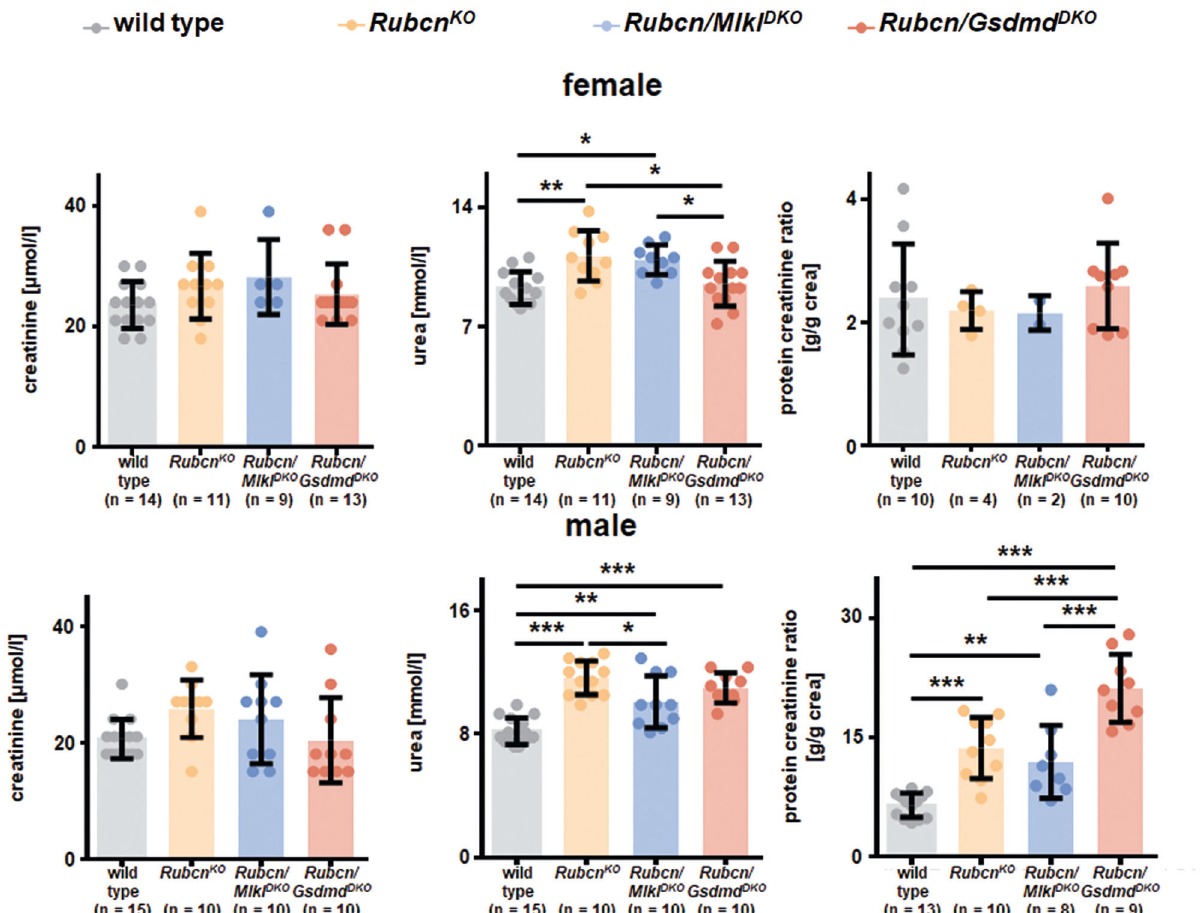
Fig. 3 Male RUBCN-de fi cient mice develop slight proteinuria and mild chronic kidney disease at 50 weeks of age. Serum levels of creatinine and urea, and the urine protein to creatinine ratio are depicted for female (upper panels) and male mice (lower panels) of indicated genotypes. Note that the axis for the urine protein to creatinine ratio is higher in the male mice which develop signi fi cant proteinuria in contrast to the female littermates. Statistical analysis was performed using one-way ANOVA analysis (* p < 0.05, ** p < 0.01, *** p <